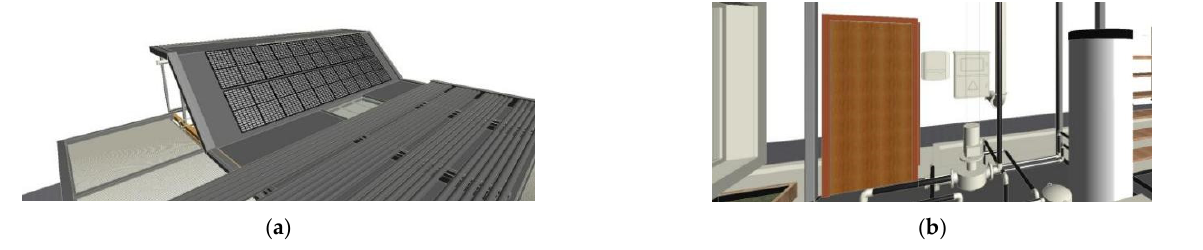
Figure 15. BIM model of PV system. ( a ) BIM model of PV modules; ( b ) BIM model of inverter and distribution box.